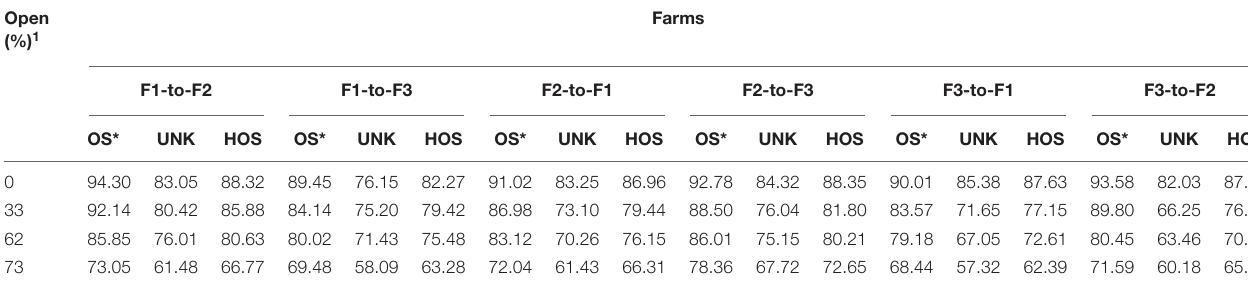
TABLE 6 | OS, UNK, and HOS accuracies (%) averaged over three runs on the tomato diseases dataset. Open (%)